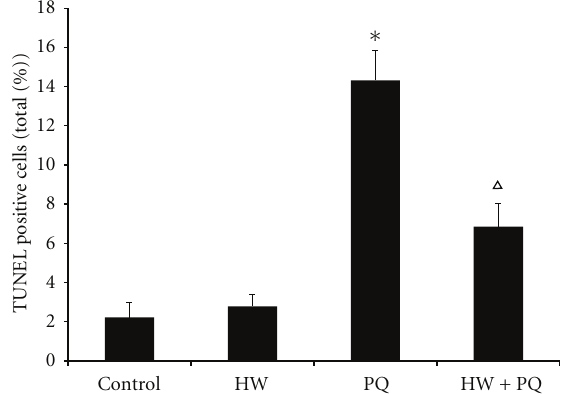
Figure 5: E ff ects of saturated hydrogen saline on cell apoptosis. Rats in the PQ group exhibit a significant induction in the lung apoptotic index compared with that in control group. Oppositely, the rats in PQ + HW group demonstrate a significant decrease in the lung apoptotic index compared with that in the PQ group, almost to the normal level ( ∗ P < . 01 compared to control; (cid:2) P < . 01 compared to PQ